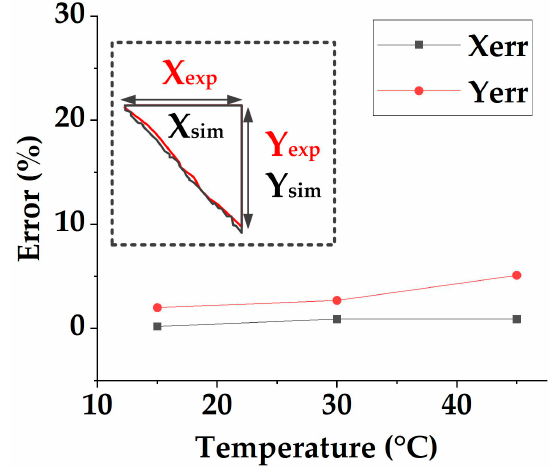
Figure 17. The forming test results at 15 °C, 30 °C and 45 °C.